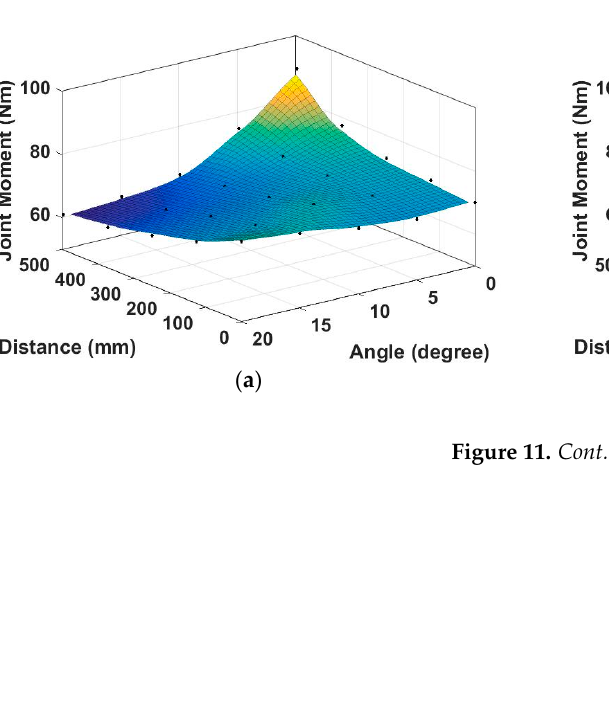
Table 9. Pearson correlation coefficients of measured and simulated joint moments (*: p < 0.001).